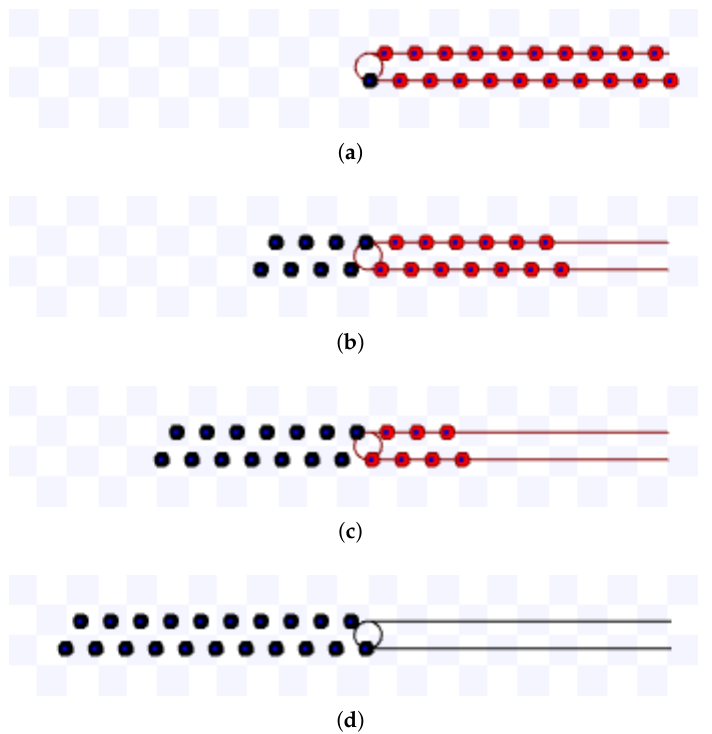
Figure 21. Simulation on Stage for compact lanes strategy using s = 0.45 m, d = 1 m during T = 10.1 s. Available on https://youtu.be/9OXGC1w83j0, accessed on 12 June 2022. ( a ) 0 s: begin- ning of the simulation; ( b ) After 3.5 s; ( c ) After 7 s; ( d ) 10.1 s: ending of the